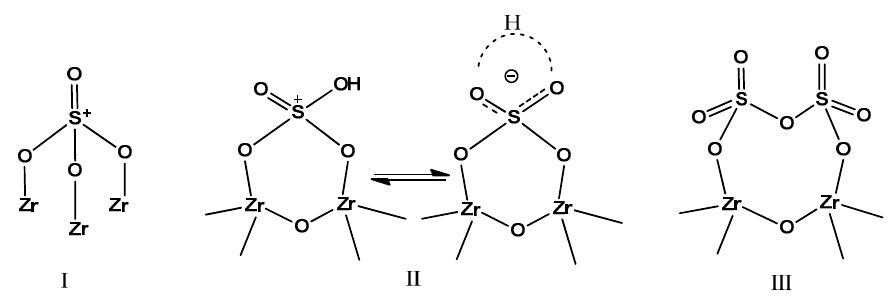
Table 2. Thermogravimetric-mass spectrometry of parent and sulfated zirconia.